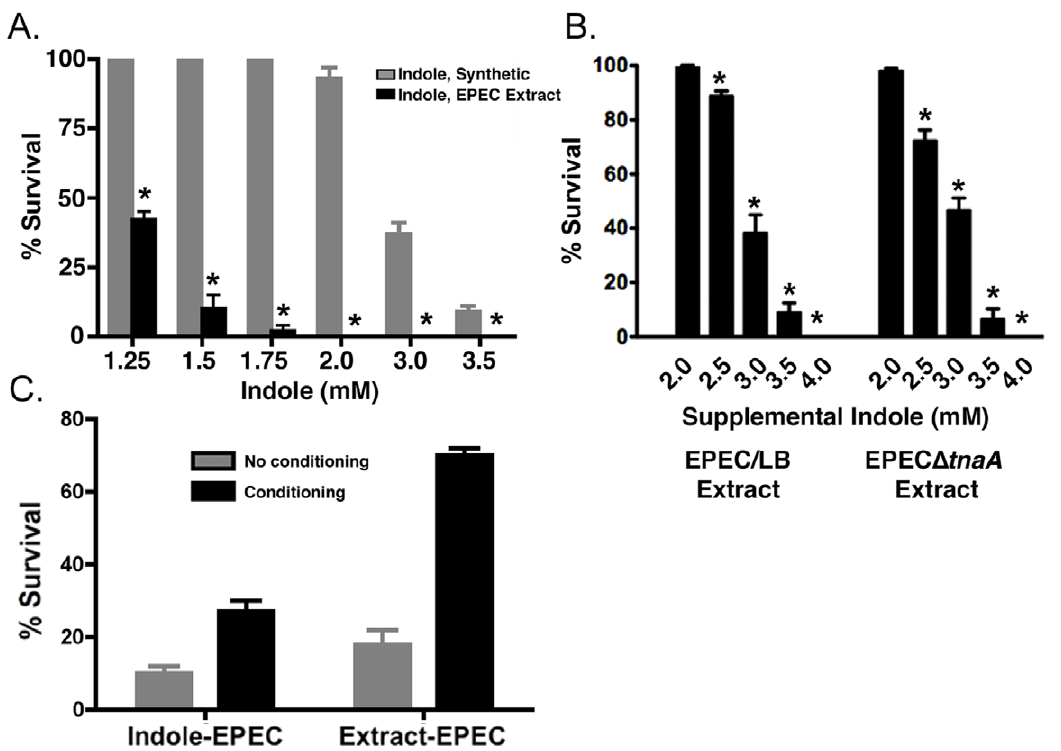
Figure 3. Effects of synthetic indole or extract on killing and conditioning of C.elegans . ( a ) Comparison of the effect of synthetic indole or of EPEC agar extracts in which the indole concentration has been estimated based on HPLC measurements of the indole concentration in identically prepared samples. Note that the LD 90 for synthetic indole is 3.5 mM, but that the extract kills even at indole concentrations of 1.5 mM, suggesting that additional factors in the extract contribute to killing. Mean + / 2 SEM are shown; * corresponds to p , 0.001 with respect to control at each dilution. ( b ) Tryptophan and tryptophanase are required for production of additional killing factors. N2 worms were exposed either to EPEC extracts from LB plates lacking tryptophan or to EPEC D tnaA extracts. Significant killing was evident in either condition only when synthetic indole was added at concentrations greater than 3 mM. Mean + / 2 SEM are shown; * corresponds to p , 0.01 with respect to control at each dilution. ( c ) Comparison of the effects of conditioning C. elegans with either 3.5 mM indole or with extract derived from EPEC/LBT plates, and challenging with EPEC. Note that extract conditions 2-fold better than indole. Mean + / 2 95% confidence intervals are shown. Lack of overlapping error bars indicates significance at the 5%